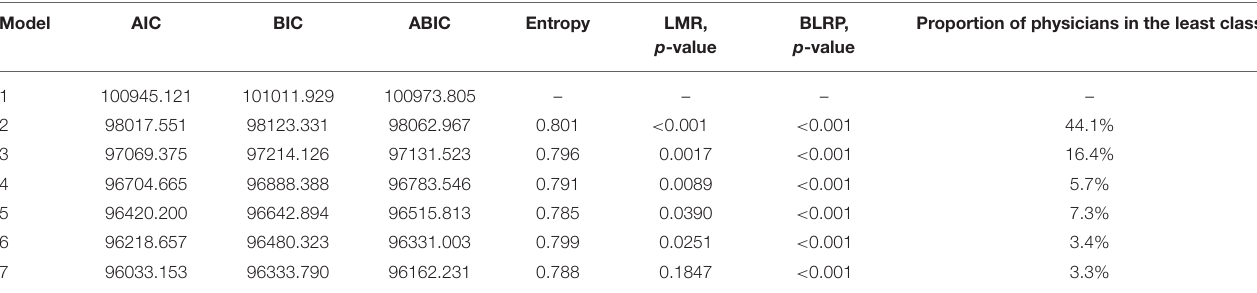
TABLE 3 | Latent profile analysis models and fit